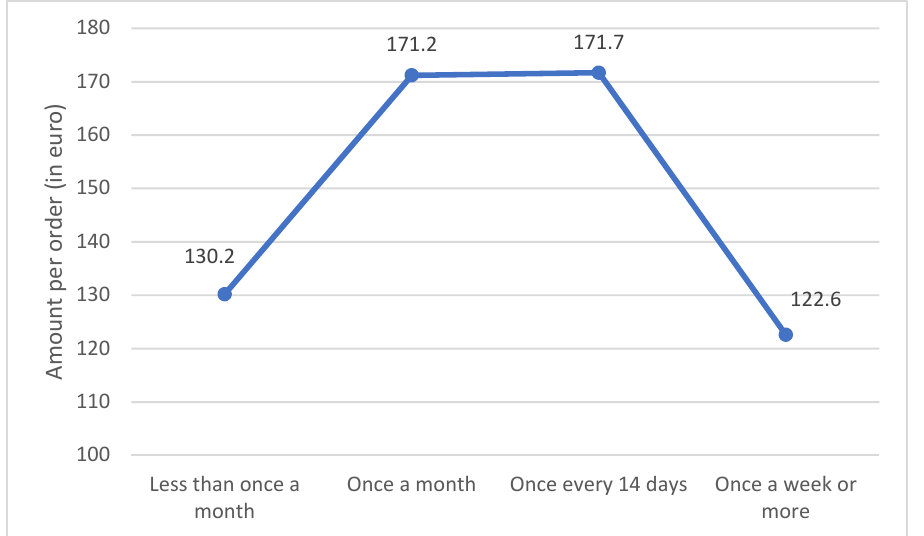
Figure A1. Average amount per order vs. order frequency.